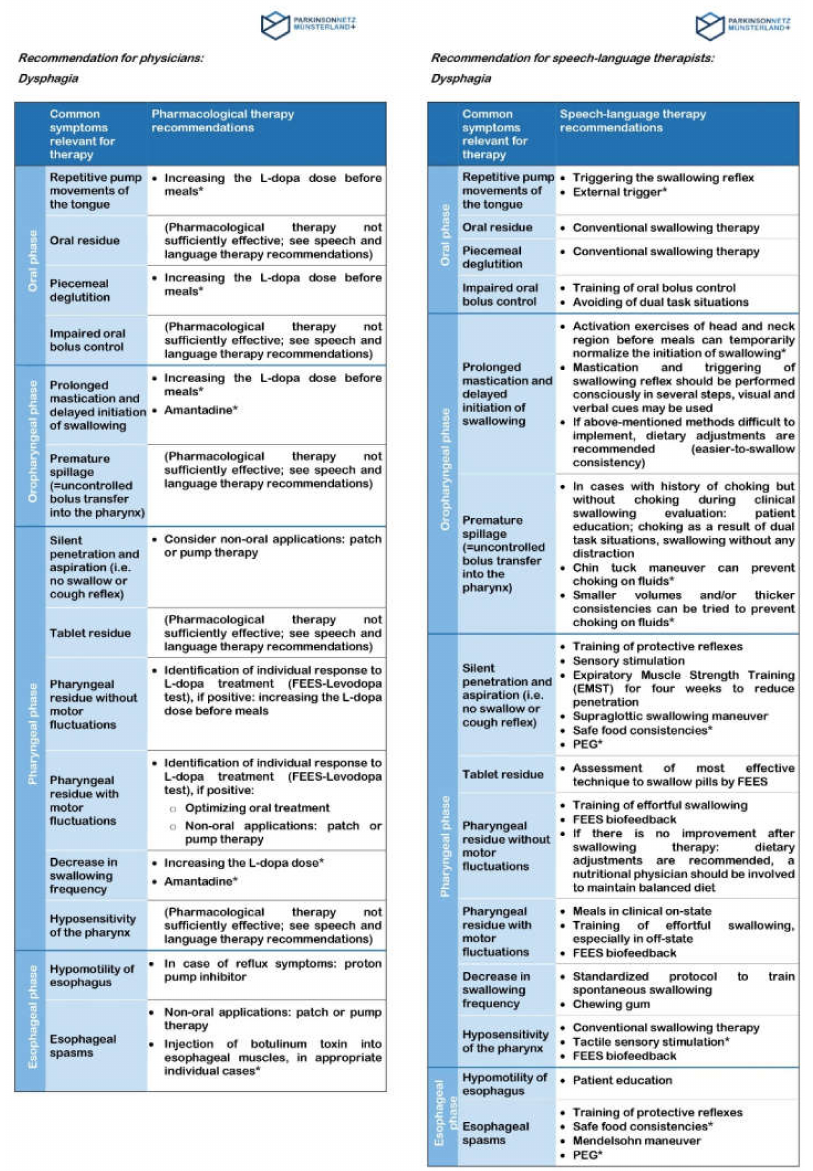
Figure 2. Quickcard Dysphagia. Notes: * Individual assessment of levodopa responsiveness of dysphagia, if positive: consider permanent treatment. Abbreviations: EMST = Expiratory Muscle Strength Training, FEES = fiberoptic endoscopic evaluation of swallowing, PEG = percutaneous endoscopic